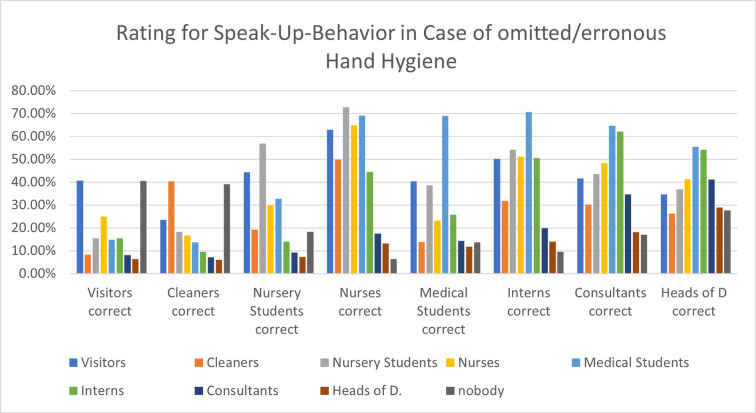
Correctional behavior perceived by medical students (groups C und C+ groups).On the Y-axis the percentages of agreements for the question if a specific group (x-Axis) corrects others (colored columns) is shown. Most corrections on others and the own profession are perceived for nurses, while cleaners and visitors are not perceived to do corrections on others. Medical students themselves feel to be corrected by all others groups. Concerning physicians, they rated to be less corrected with rising levels of hierarchy.